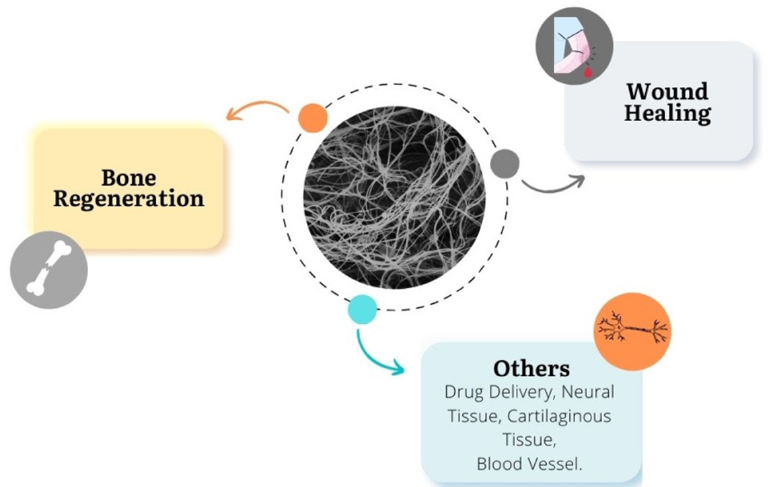
Figure 1. Possible applications of ceramic nanofibers.